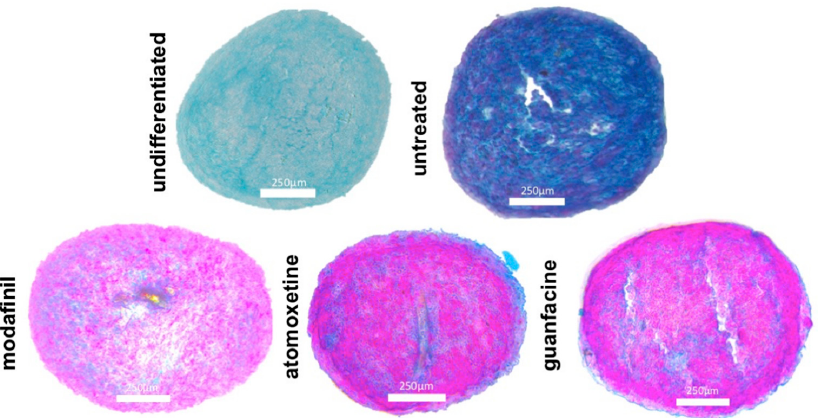
Figure 4. Chondrogenic differentiation of mesenchymal stem cell spheroids for 21 days. Alcian blue nuclear fast red stained images of untreated, modafinil (11.2 µg/mL)-, atomoxetine- (0.9 nuclear fast red stained images of untreated, modafinil (11.2 µ g/mL)-, atomoxetine- (0.9 µ g/mL) and µg/mL) and guanfacine- (17,675 ng/mL) treated chondrogenic spheroids. Scale bar 250 µm. guanfacine- (17,675 ng/mL) treated chondrogenic spheroids. Scale bar 250 µ